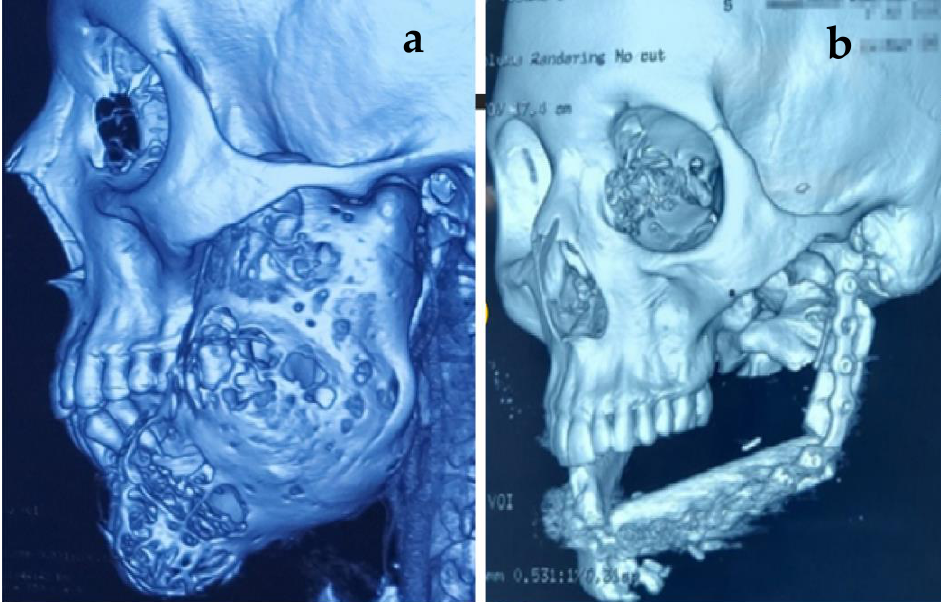
Figure 4. ( a , b ) 3D computed tomography of patient with ameloblastoma showing hemimandibular defect (Class II) reconstructed; transplanted fibula bone placed at the alveolar level to facilitate future implant rehabilitation.